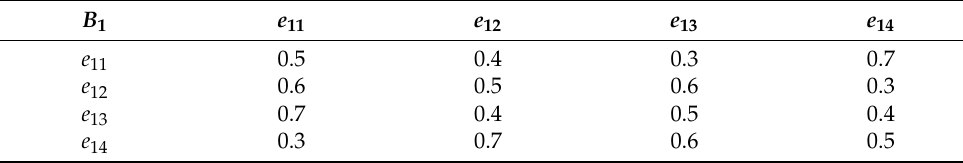
Table A18. Fuzzy symmetric matrix for influencing factors of hydrology-climate B 1